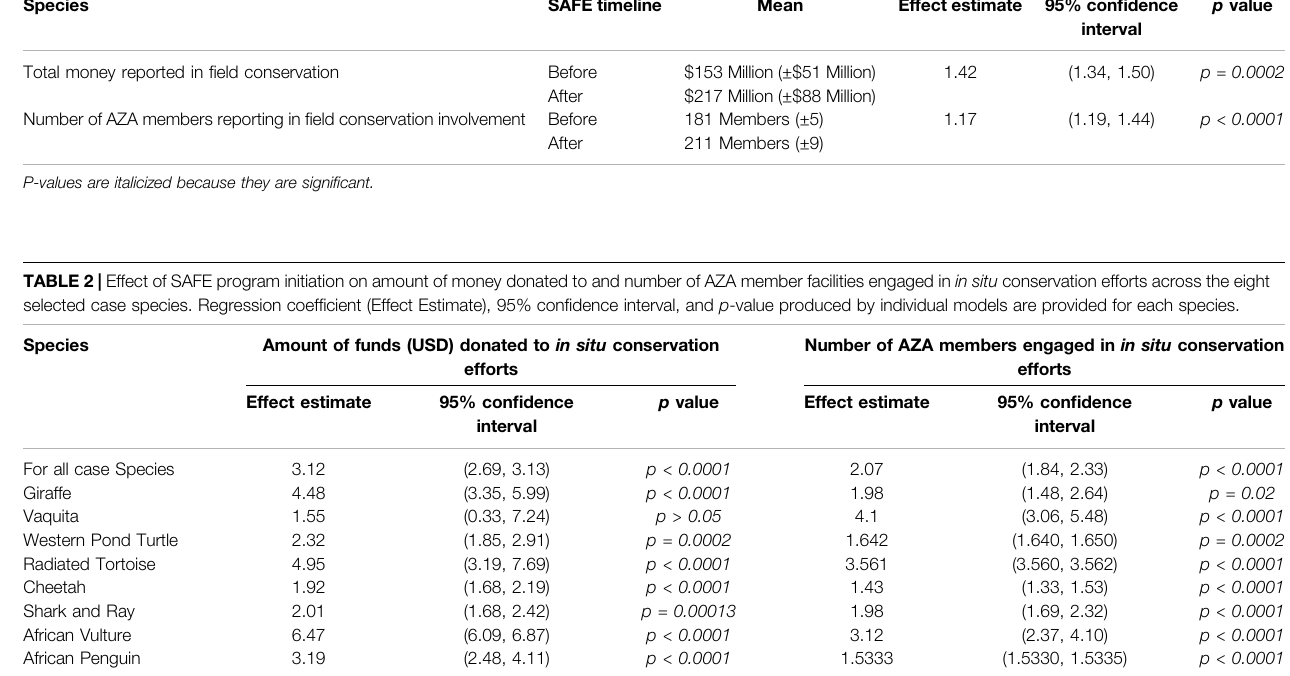
TABLE 1 | AZA Member contribution and engagement in in situ conservation projects before and after initiation of SAFE conservation programs in 2015. Model estimated meansareprovided foreachvariablelevel,andregressioncoef fi cient(EffectEstimate),95%con fi denceinterval,and p -valueareprovided foreachpairwisecomparison. Species